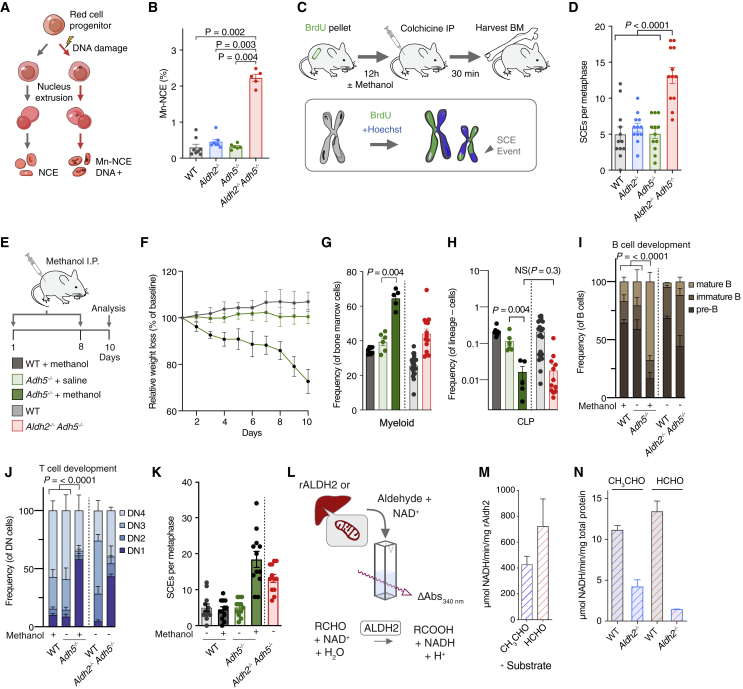
DNA Damage in Aldh2−/−Adh5−/− Mice and Methanol Challenge of Adh5−/− Mice Phenocopies the Double Mutant(A) Scheme of the micronucleus assay.(B) Micronuclei in Aldh2−/−Adh5−/− mice and controls. (mean ± SEM, n = 8, 7, 6, 5, left to right).(C) SCE analysis in bone marrow cells.(D) Quantification of SCE in Aldh2−/−Adh5−/− mice and controls. (mean ± SEM, n = 12 metaphases per group).(E) Treatment of mice with intraperitoneal methanol injection.(F) Percentage of weight loss relative to baseline weight on day 0 (mean ± SD, n = 10; WT + methanol, 6; Adh5−/− + saline and 6; Adh5−/− + methanol).(G and H) Frequency of bone marrow myeloid (CD11b+ Gr-1+) and CLP cells (mean ± SEM, n = 8, 6, 5, left to right).(I and J), Frequency of bone marrow B cell (pre-B, immature and mature) and thymus DN populations (DN1–DN4) (mean and SEM; n = 8, 6, 5 mice, left to right).(K) Quantification of SCEs of methanol-treated mice and controls. n = 12 metaphases per group.(L) ALDH activity assays on recombinant ALDH2 (rALDH2) or mitochondrial extracts from WT or Aldh2−/− liver.(M and N) ALDH activity performed with acetaldehyde (CH3CHO) and formaldehyde (HCHO) substrates using rALDH2 (M); WT and Aldh2−/− liver mitochondrial extract (N). Activity is expressed as micromolar NADH per minute per milligram of total protein (mean and SD; n = 2).The p values were determined by two-tailed Mann-Whitney U test, except for (I) and (J), where pairwise χ2 tests of average distributions were performed. See also Figures S3 and S4.